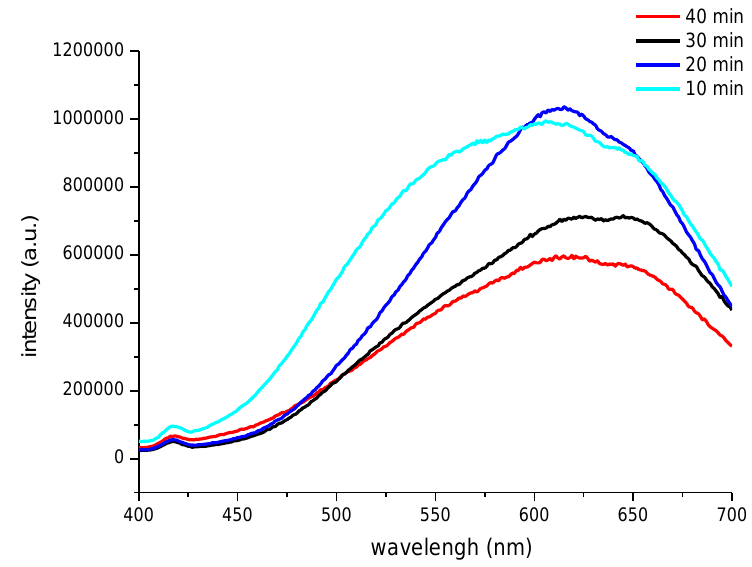
Figure 4. The PL spectra of the CNF/CdS nanocomposites with different Na 2 S feeding time (excitation wavelength 365 nm).